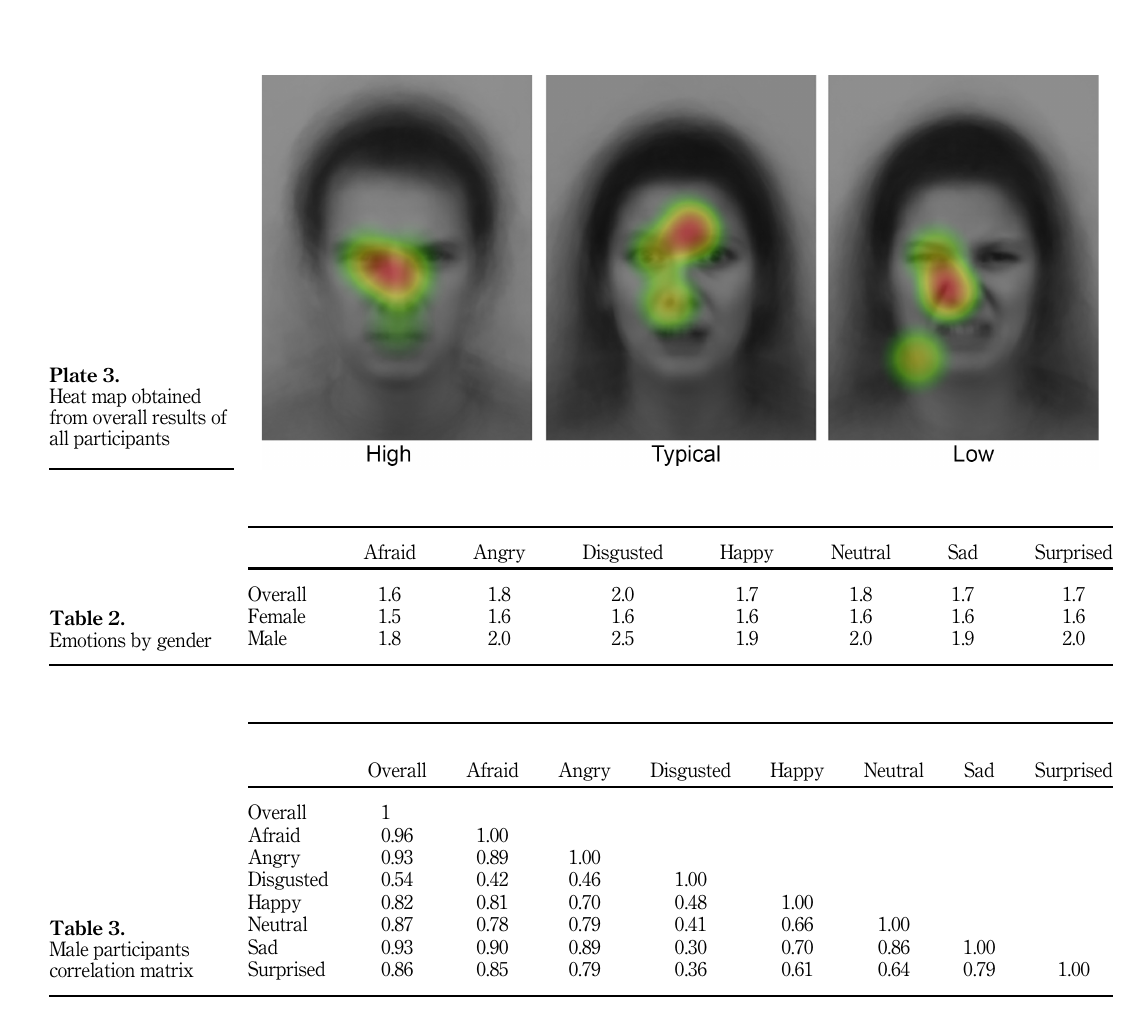
Table 1. Overall scores